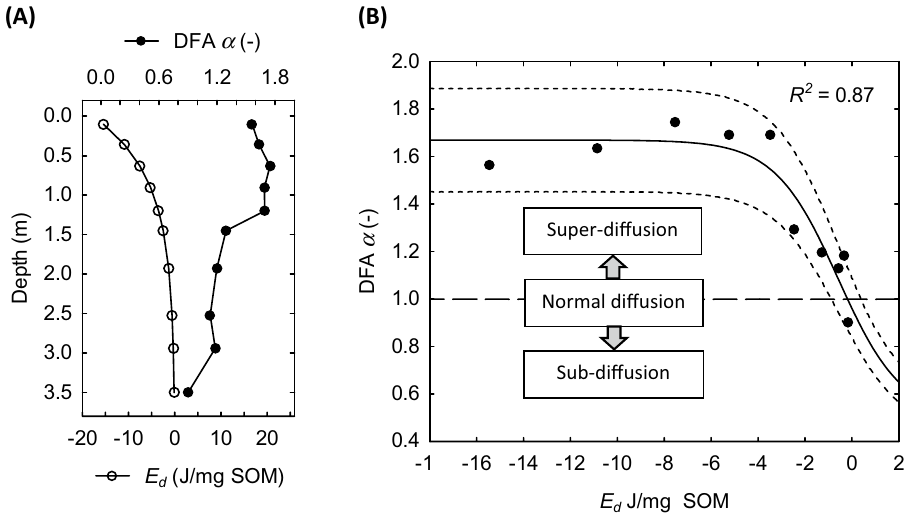
Figure 3. Soil depth profiles for (A) DFA α value scaling exponents with corresponding estimates for soil organic matter (SOM) energy density values, and (B) DFA α value scaling exponents as a function of soil organic matter (SOM) energy density values; dashed lines are prediction intervals at p values that represent the proportion of variance accounted for by the regression ( R 2